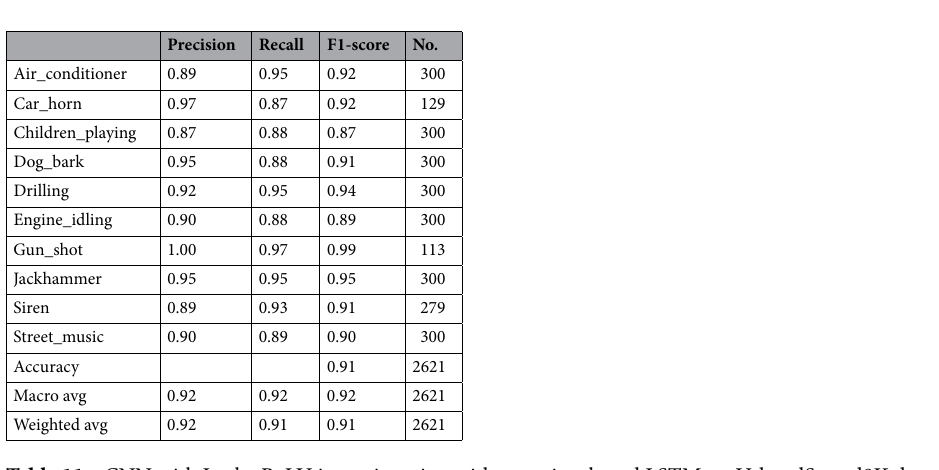
Table 11. CNN with Leaky ReLU in conjunction with attention-based LSTM on UrbandSound8K dataset. No. indicates the number of samples.